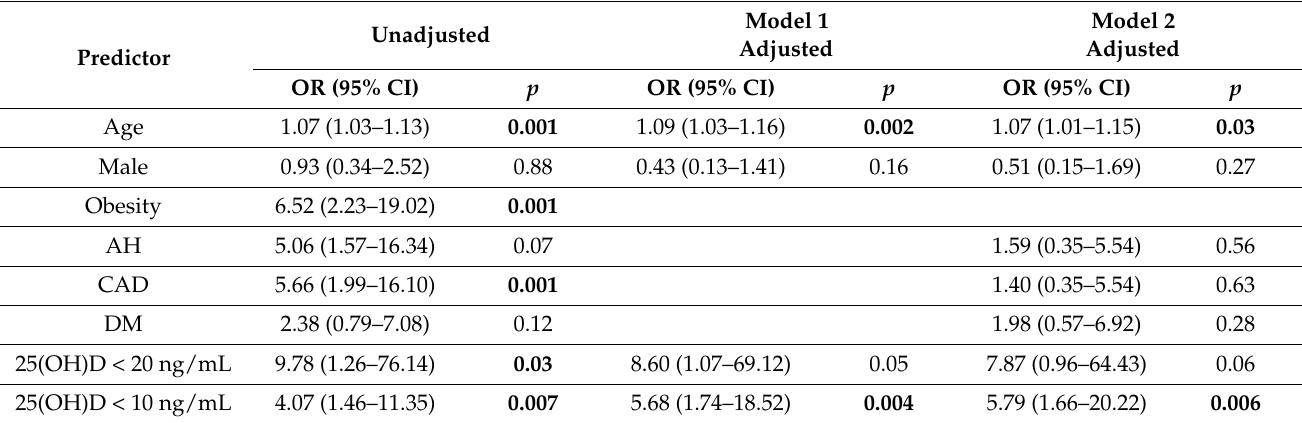
Table 5. Predictors for COVID-19 fatal outcome (logistic regression